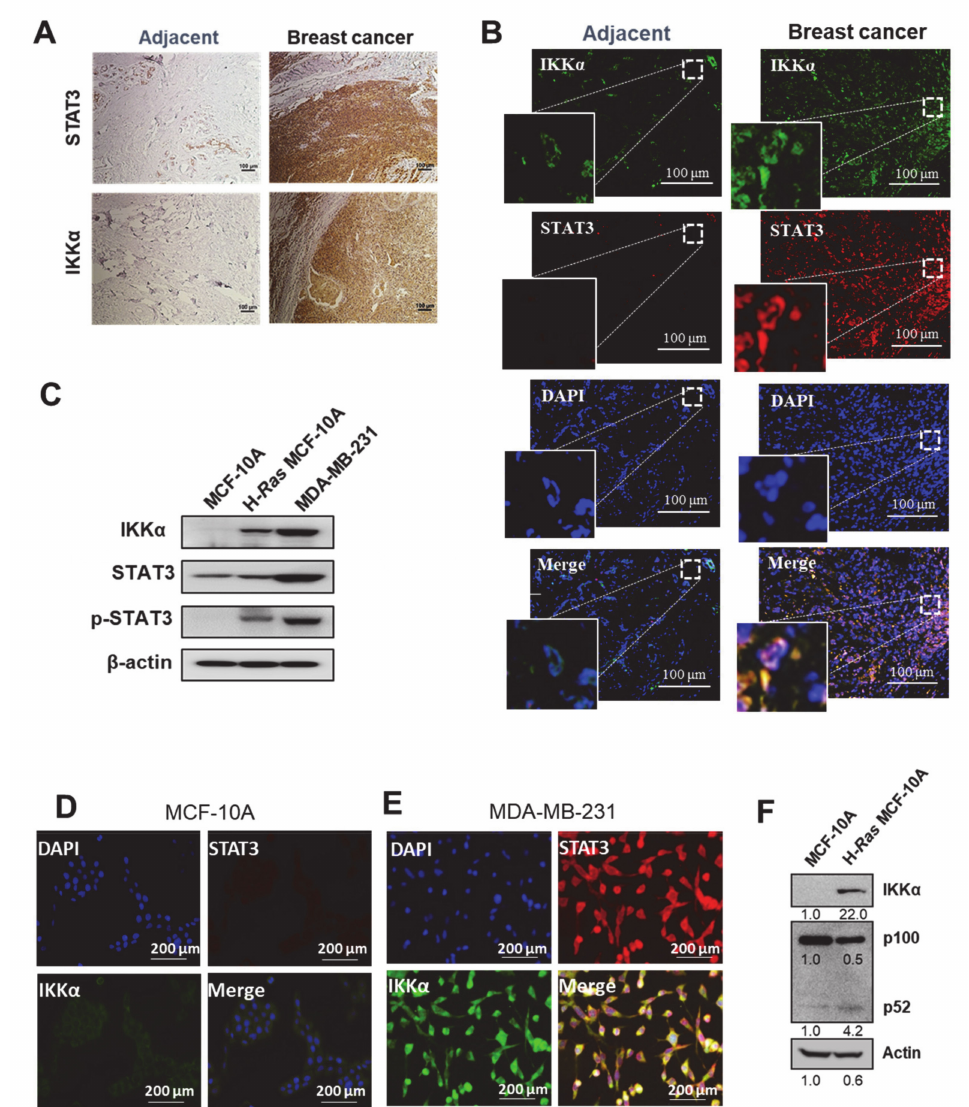
Figure 1. Co-expression of STAT3 and IKK α in human breast carcinoma. ( A , B ) Frozen sections from human breast carcinoma and its normal adjacent tissues were stained with antibodies against STAT3 or IKK α . The representative images were obtained by immunohistochemical ( A ) and immunofluorescence ( B ) analyses. 4 (cid:48) ,6-Diamidino-2-phenylindole (DAPI), nuclear staining for immunofluorescence. Scale bar, 100 µ m. ( C ) Immunoblot analysis shows comparative expression levels of IKK α , phospho-STAT3 (p-STAT3) and STAT3 in MCF-10A, H- Ras MCF-10A, and MDA-MB-231 cells. Actin was used as an equal loading control. ( D , E ) Immunofluorescence analysis of IKK α and STAT3 in MCF-10A ( D ) and MDA-MB-231 ( E ) cells. DAPI, nuclear staining for immunofluorescence. Scale bar, 200 µ m. ( F ) Immunoblot analysis showing comparative expression levels of IKK α , p100, and its cleaved form p52 in MCF-10A and H- Ras MCF-10A